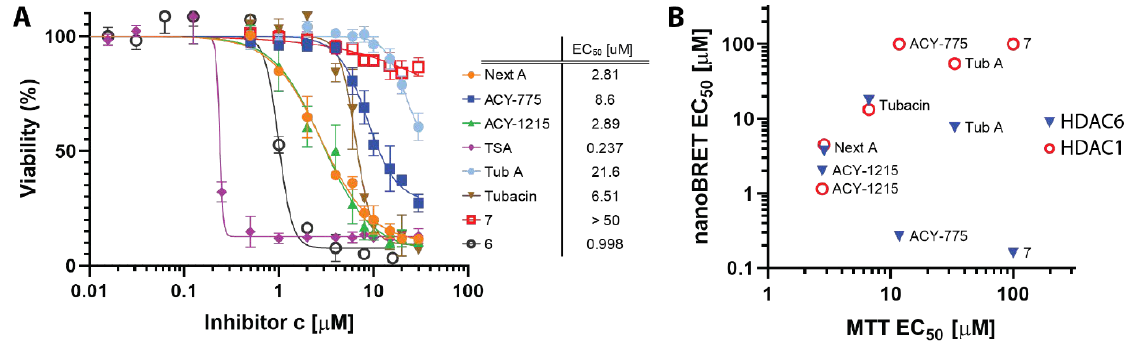
Figure 4. Cytotoxicity of HDAC6is. Panel ( A ) RPMI-8226 cells were treated with dilution series of HDAC6is for 48 h and cell viability was determined using the MTT assay. Signals were normalized and expressed as viability in %, where 100% was set to the control without inhibitor. Experiments were conducted in tetraplicates, and mean viability ± standard deviation is plotted against inhibitor concentration . Panel ( B ) EC 50 values of tested compounds in the nanoBRET target engagement assay (both HDAC1 and HDAC6) are plotted against EC 50 values from the MTT viability assay and their correlation is analyzed by GraphPad Prism software (version 8.0.1). While nanoBRET-HDAC1 vs MTT correlate well (correlation coefficient r = 0.917; p -value = 0.0048), no correlation was observed for nanoBRET-HDAC6 and MTT (r = − 0.179; p = 0.713). For ACY-775 and 7 , the fitted EC 50 s are higher than 100 µM, which is more than the highest concentration in the assay (50 µM), and thus the calculated values are not reliable. For the purpose of this chart, we have capped the values at 100 µM.